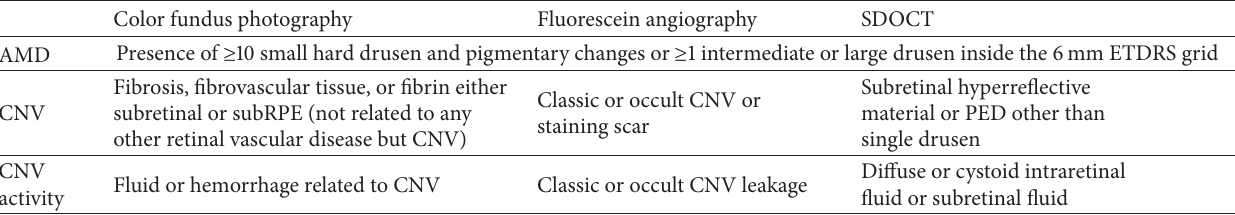
Table 1: Parameters evaluated as signs for AMD, CNV, and CNV